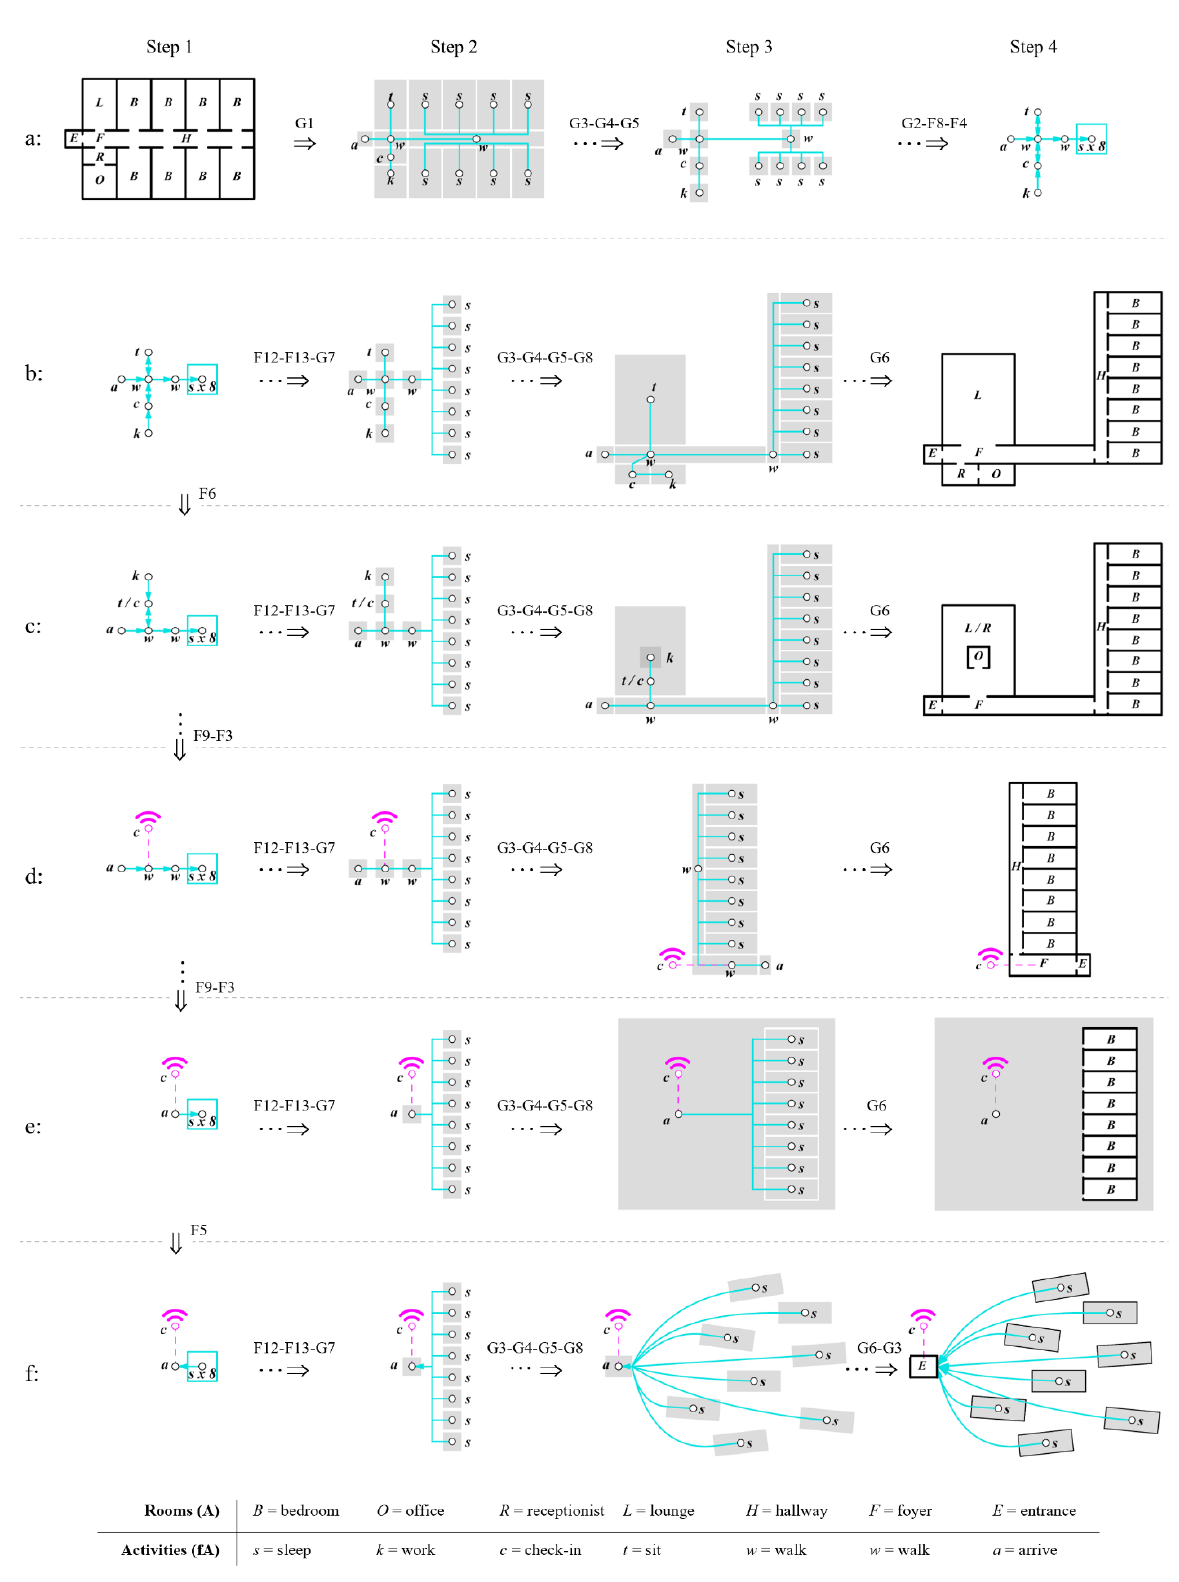
Figure 7. Graph and shape rule iterations for a hotel lobby ( a – f ). Graph-to-graph iteration is shown in the vertical direction (left-hand column) and graph-to-shape iteration in the horizontal direction.